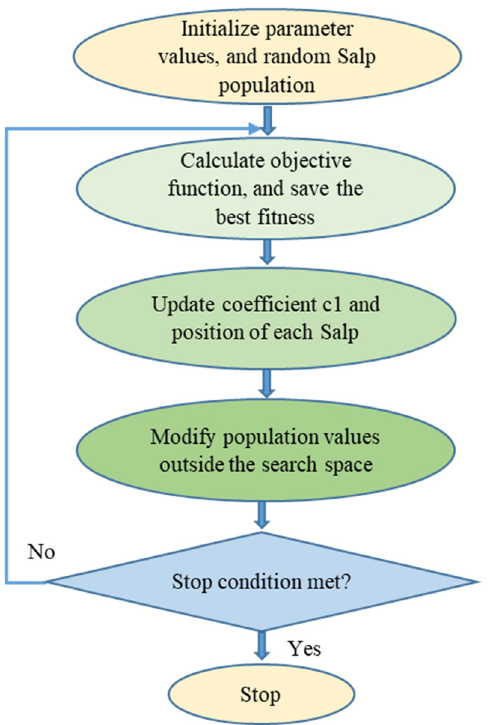
Figure 3: The basic SSA